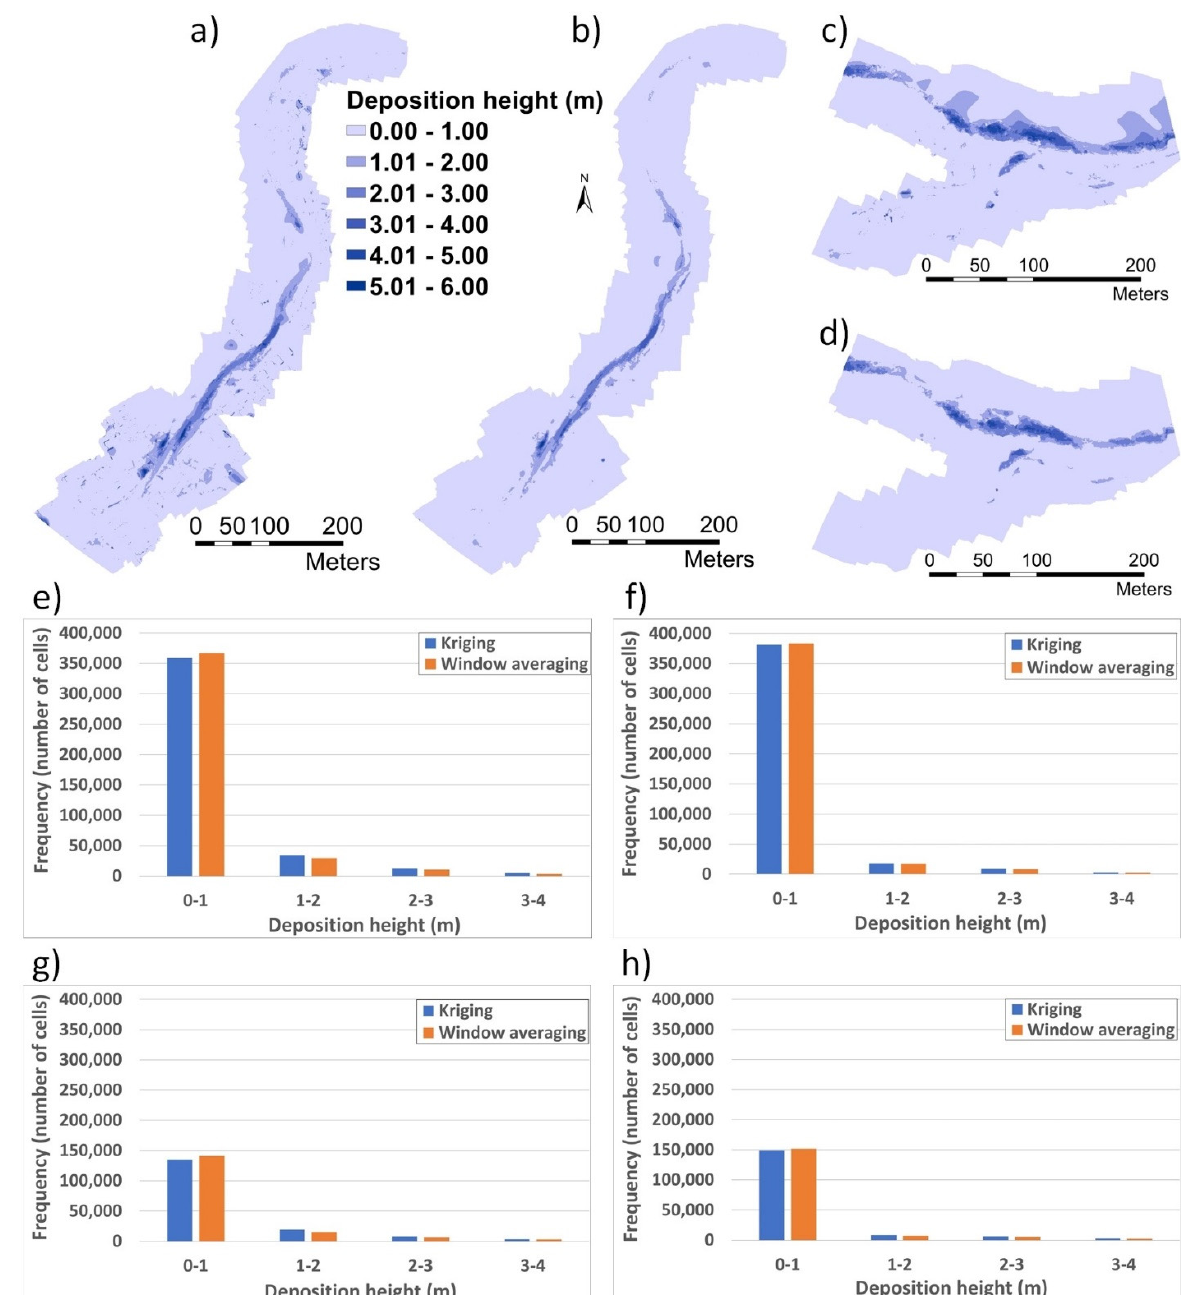
Figure 7. ( a ) Coulibistrie UAV-DSM-DoD filled with window averaging. ( b ) Coulibistrie LiDAR-DTM-DoD filled with window averaging. ( c ) Pichelin UAV-DSM-DoD filled with window averaging. ( d ) Pichelin LiDAR-DTM-DoD filled with window averaging. ( e ) Histogram comparing the cell values of UAV-DSM-DoD for Coulibistrie filled with the two approaches (Kriging versus window averaging). ( f ) Histogram comparing the cell values of LiDAR-DTM-DoD for Coulibistrie filled with the two approaches. ( g ) Histogram comparing the cell values of UAV-DSM-DoD for Pichelin filled with the two approaches. ( h ) Histogram comparing the cell values of LiDAR-DTM-DoD for Pichelin filled with the two